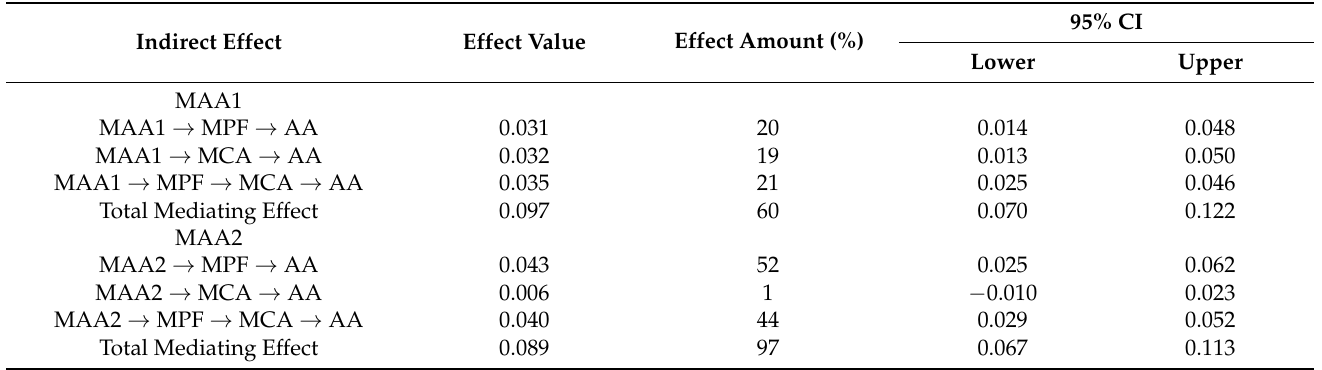
Table 2. Bootstrap confidence interval and effect size of the indirect effect model (N =